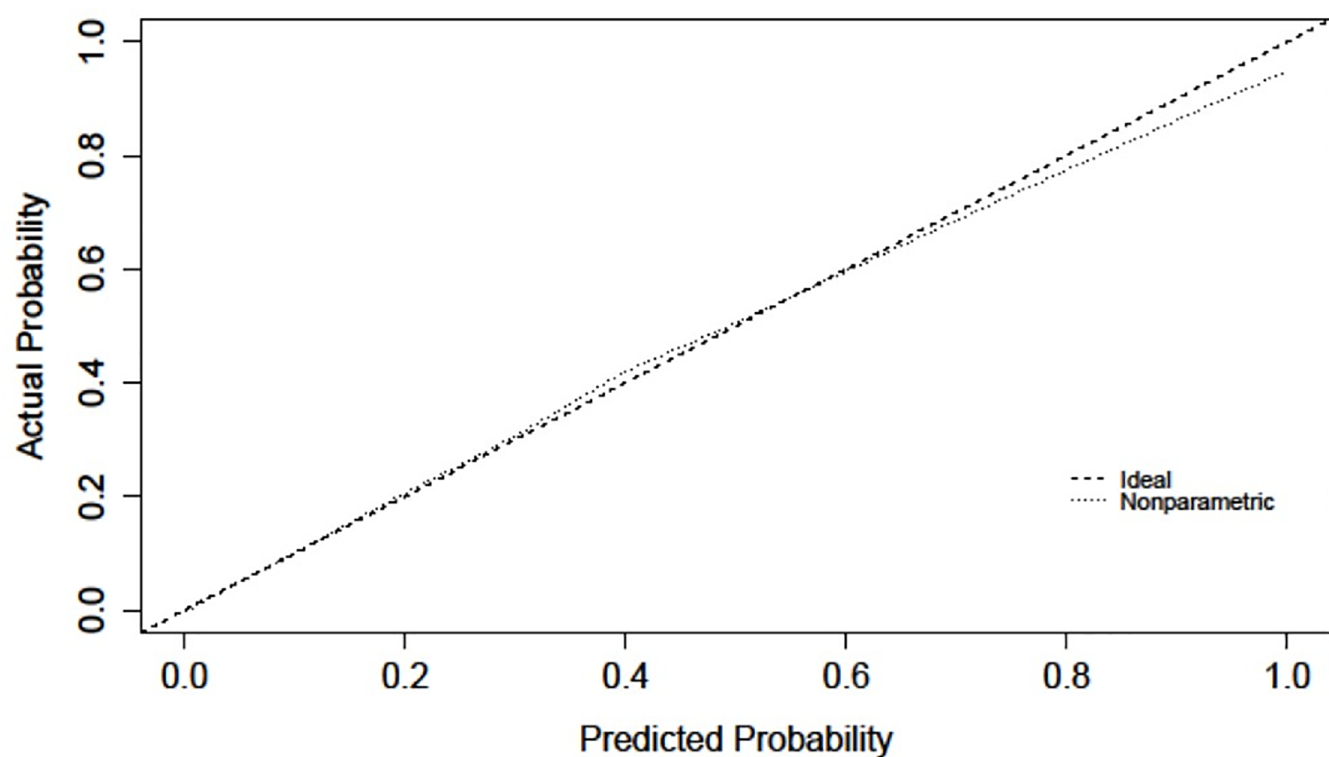
Fig 1. Calibration plot demonstrating the relationship between predicted and observed risk among